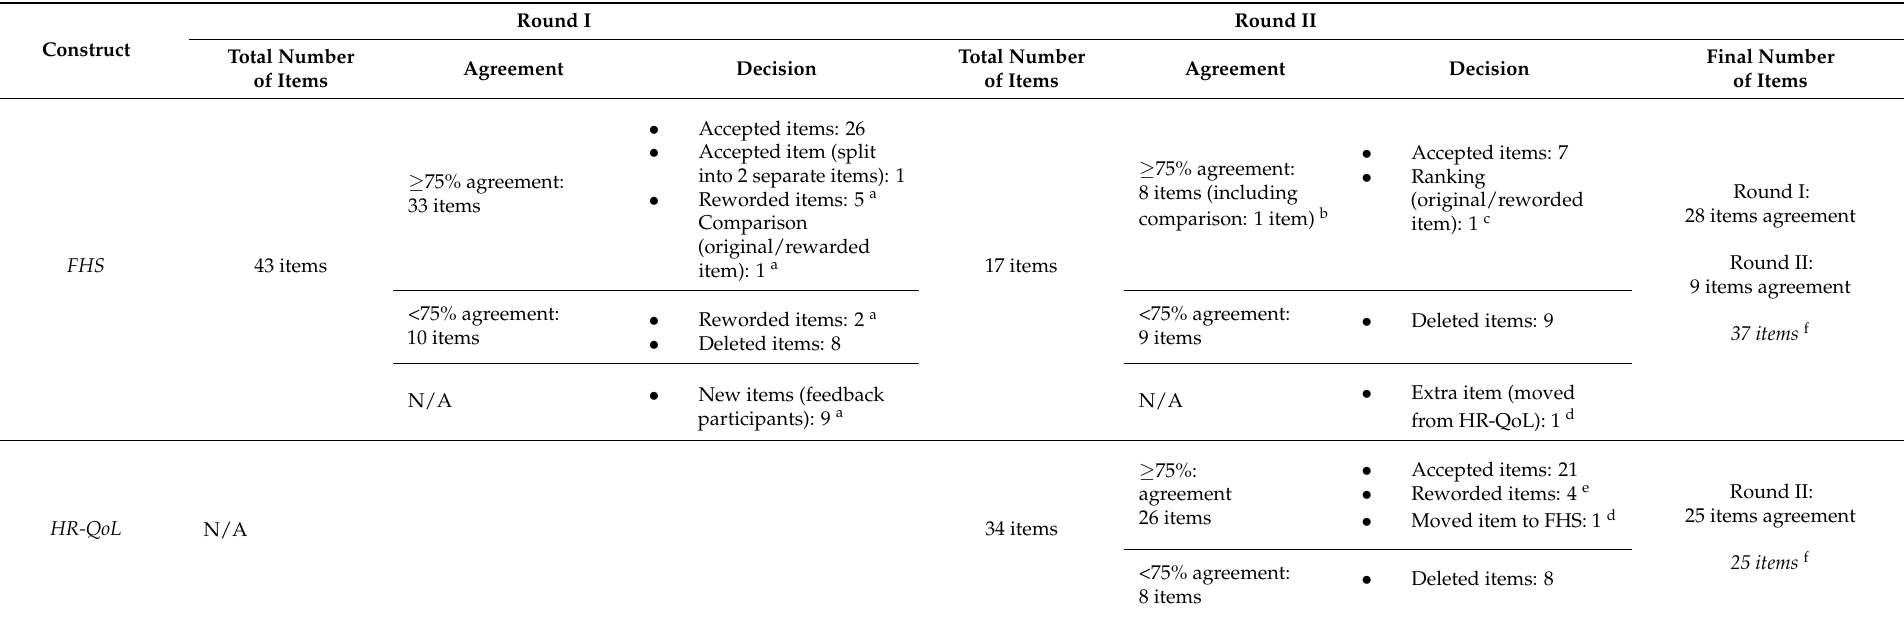
Table 2. Decision flow chart for items on FHS and HR-QoL: Delphi Round I and